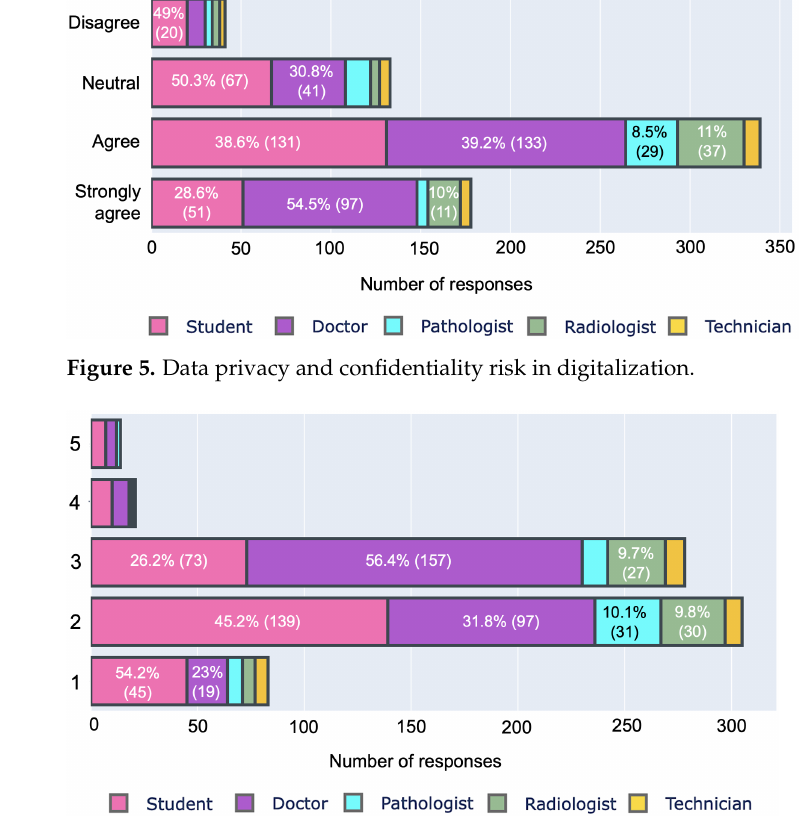
Figure 6. Rating of outside-city healthcare service on a scale of 1–5, if 5 is the city healthcare.